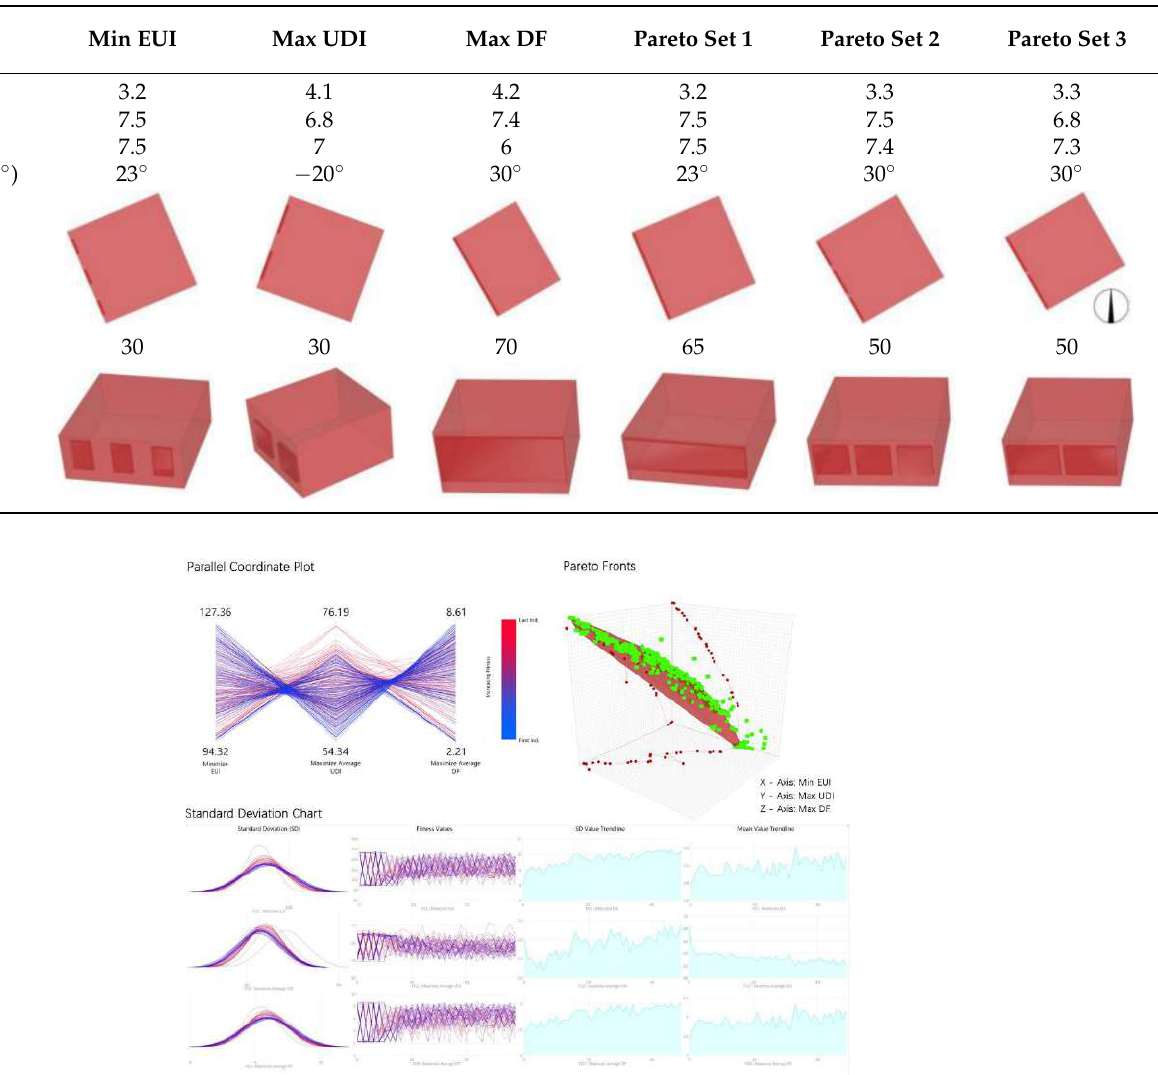
Table 8. Genomes in detail and phenotype output for small-sized classrooms with west facade fenestration.